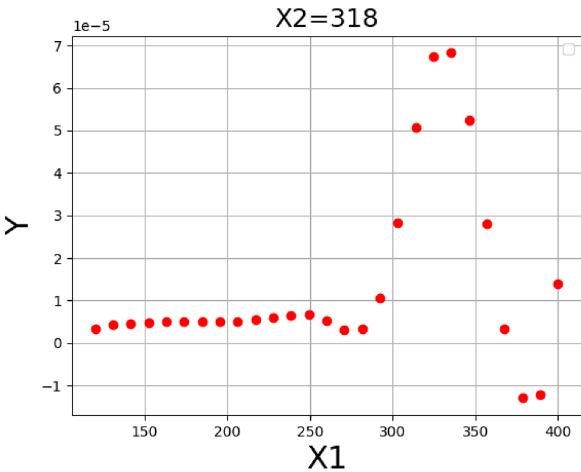
Figure 6. Solubility based on pressure/Y: solubility/X 1 : pressure.